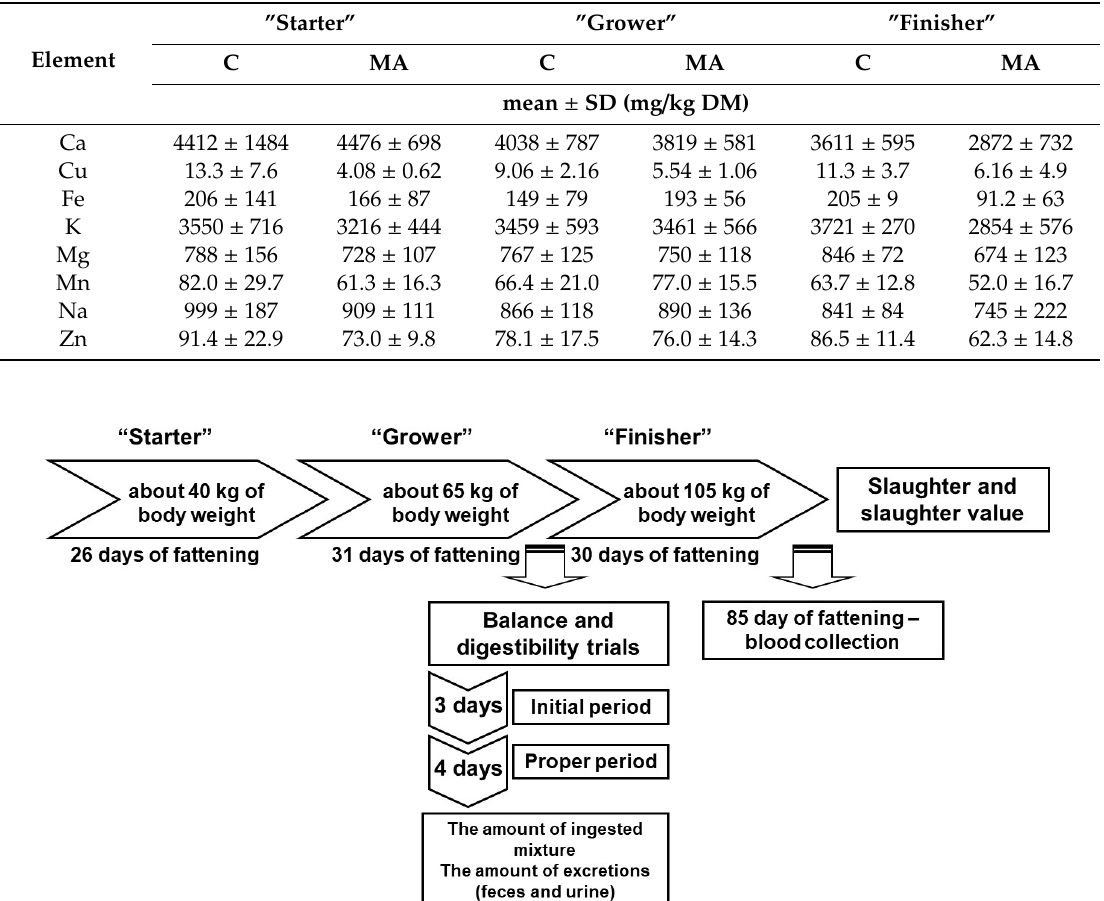
Figure 1. General scheme of feeding experiment on growing pigs.